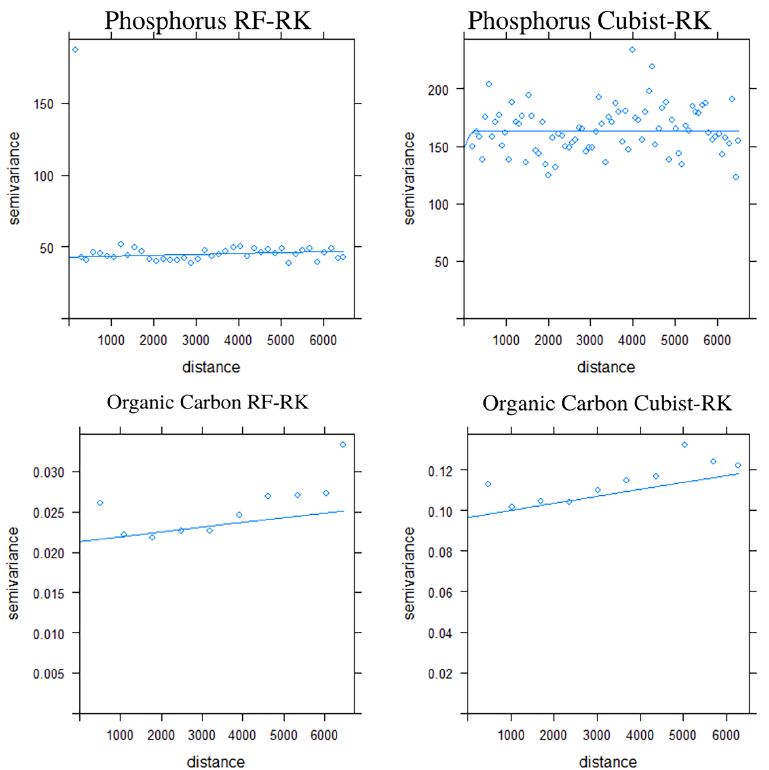
Figure 5. Variograms and fitted models. Abbreviations: RF-RK: random forest combined with kriging, RK: regression kriging. Table 5. Semi variogram model properties of model residuals for phosphorus and organic carbon using random forest and cubist models.